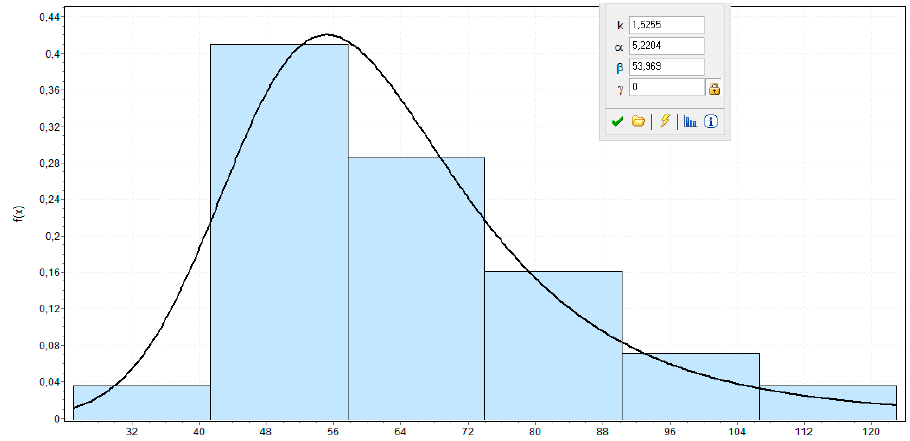
Figure 1. Density function of the Dagum distribution as a function of its parameters.